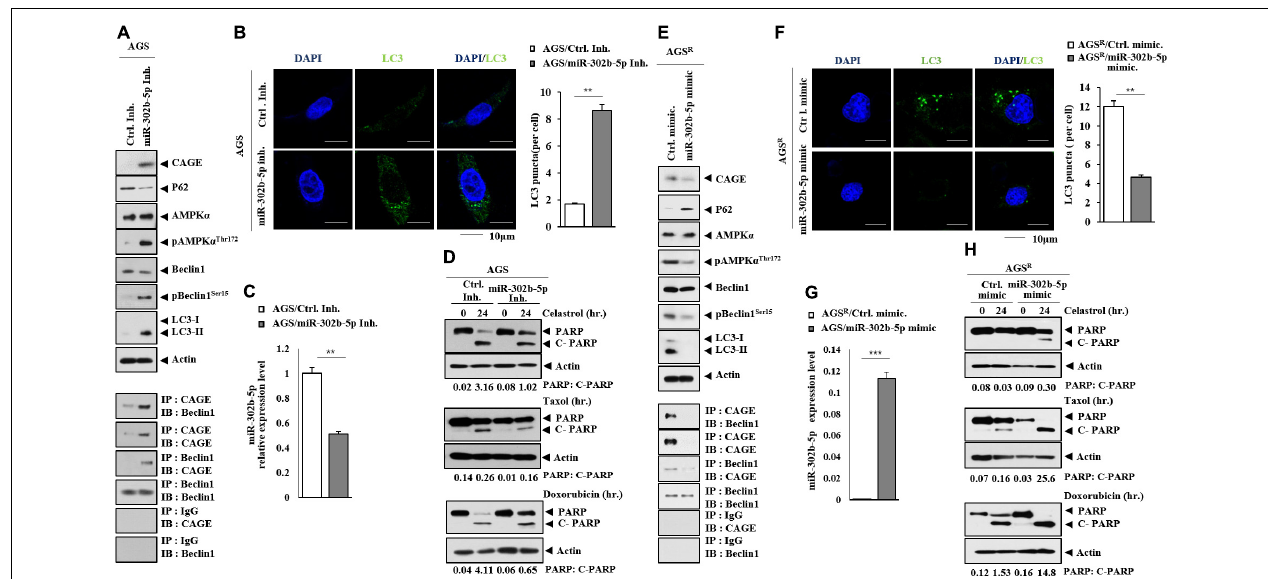
FIGURE 5 | MiR-302b-5p regulates autophagic flux and anticancer drug resistance. (A) After 48 h of transfection with the indicated inhibitor (each at 10 nM), immunoblot and immunoprecipitation were performed. Representative blots of three independent experiments are shown. (B) Same as (A) except that immunofluorescence staining was performed. **, p < 0.01. (C) qRT-PCR was performed. **, p < 0.01. Average values of three independent experiments are shown. (D) AGS cells were transfected with the indicated inhibitor (each at 10 nM). The following day, cells were then treated with or without celastrol (1 µ M), Taxol (1 µ M), or doxorubicin (1 µ M) for 24 h. Representative blots of three independent experiments are shown. (E) After 48 h of transfection with the indicated mimic (each at 10 nM), immunoblot and immunoprecipitation were performed. Representative blots of three independent experiments are shown. (F) Same as (E) except that the number of LC3 puncta was determined. **, p < 0.01. (G) qRT-PCR analysis was performed. ***, p < 0.001. Average values of three independent experiments are shown. (H) AGS R cells were transfected with the indicated mimic (each at 10 nM). The next day, cells were then treated with or without celastrol (1 µ M), Taxol (1 µ M), or doxorubicin (1 µ M) for 24 h. Representative blots of three independent experiments are